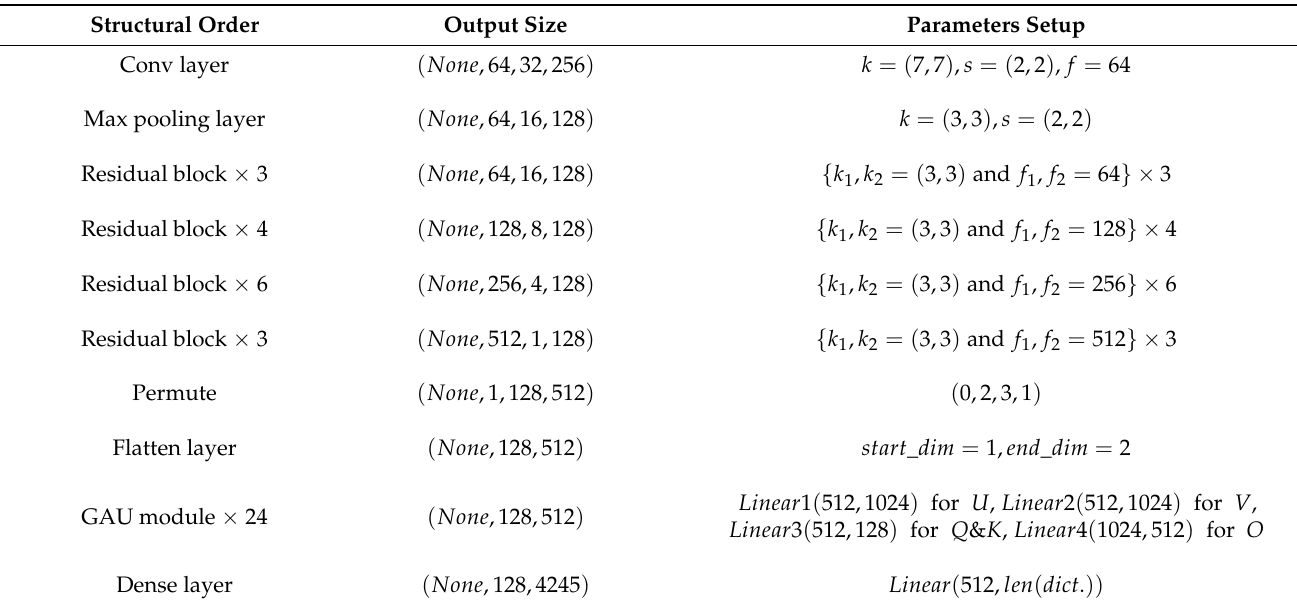
Table 2. Details of architecture. (input: Mel spectrogram with shape equal to ( None ,3,64,512 ) ).